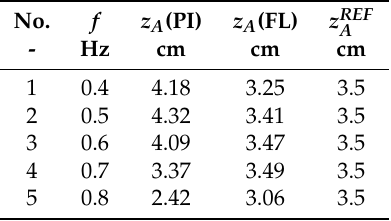
Table 2. The harmonic amplitudes of the progressive sinusoidal waves generated with the fuzzy-logic FL versus proportional-integral PI control